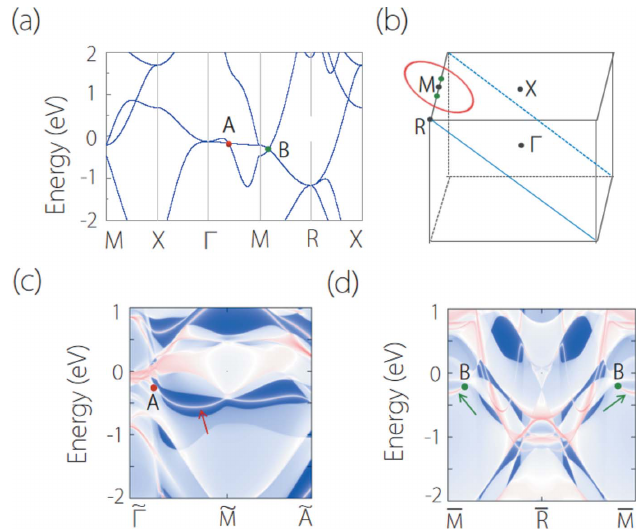
Figure 13 ( a ) Electronic band structure of YMg. The band crossing points at the (cid:2) – M and M – R paths are denoting as point A and point B, respectively. ( b ) Brillouin zone of the bulk for YMg. The green points and red circle denote the position of the triple nodal point and nodal line. ( c ) (101) surface spectrum and ( d ) (001) surface spectrum for YMg. In ( c ) and ( d ), the surface bands originating from nodal line and triple nodal point are indicated by the